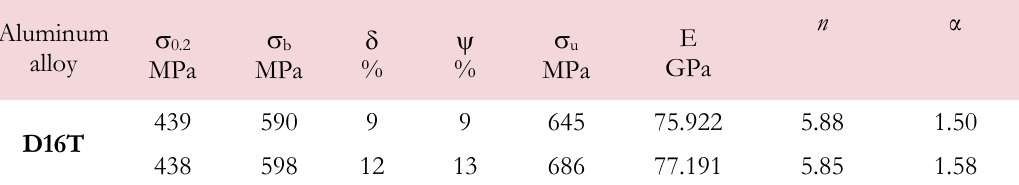
Table 1: Main mechanical properties of aluminum